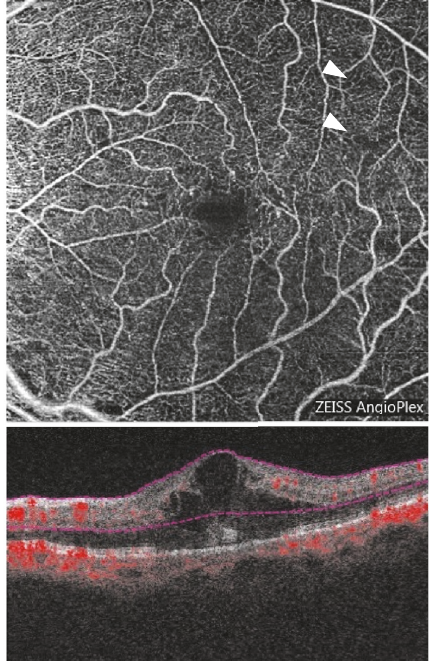
Figure 2: An OCTA image of the superficial capillary plexus in the left eye shows loss of small capillaries (arrowheads) in the upper right